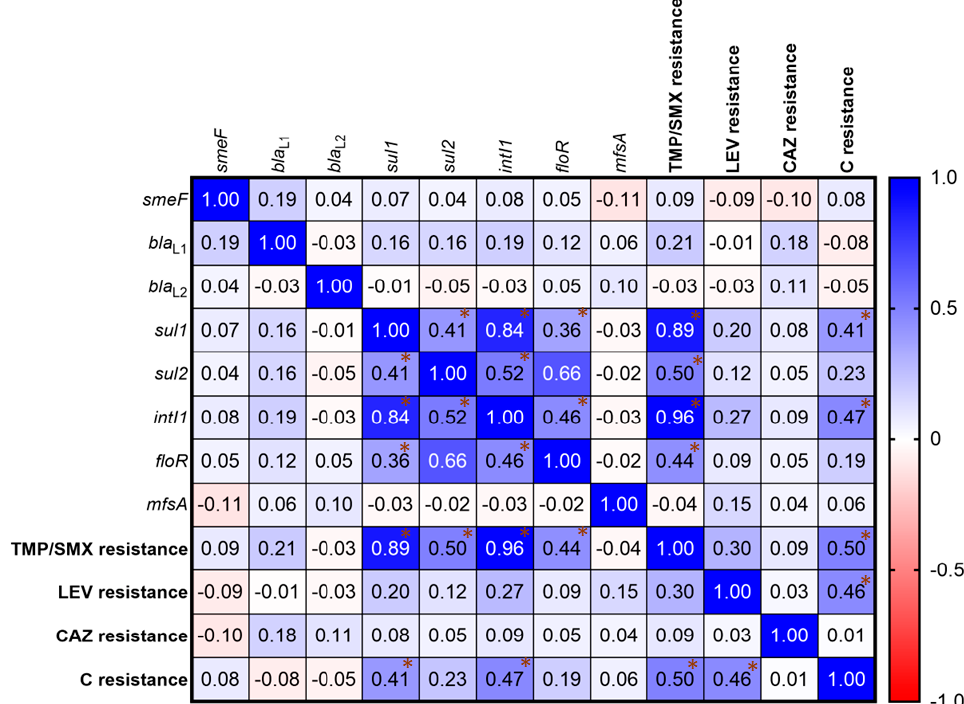
Figure 3. Correlation matrix of S. maltophilia antibiotic resistances. The relationships were determined by Spearman correlation coefficients. A heat map shows the Spearman r value indicating a correlation between the presence of drug-resistance genes and drug-resistant phenotypes. The gradient of positive and negative values shows a positive correlation (Blue) and a negative correlation (Red). Asterisk (*) shows the r value exhibiting the significant correlation. A statistical significance of the correlation was set at p < 0.05.